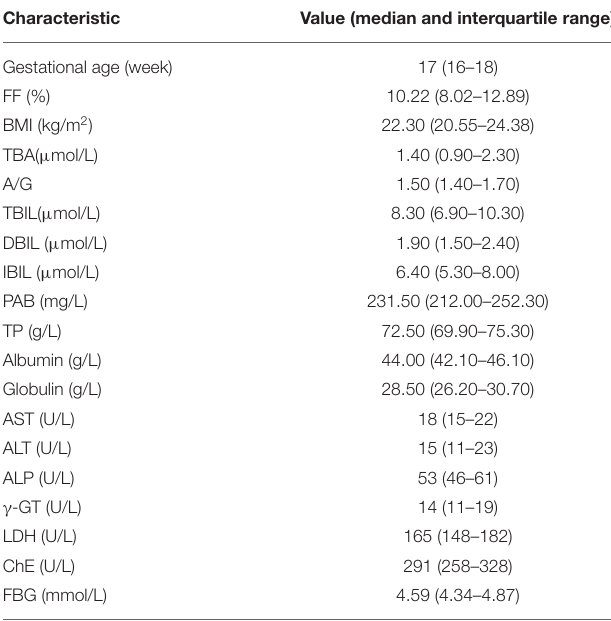
TABLE 1 | Sample characteristics of the study population ( n =